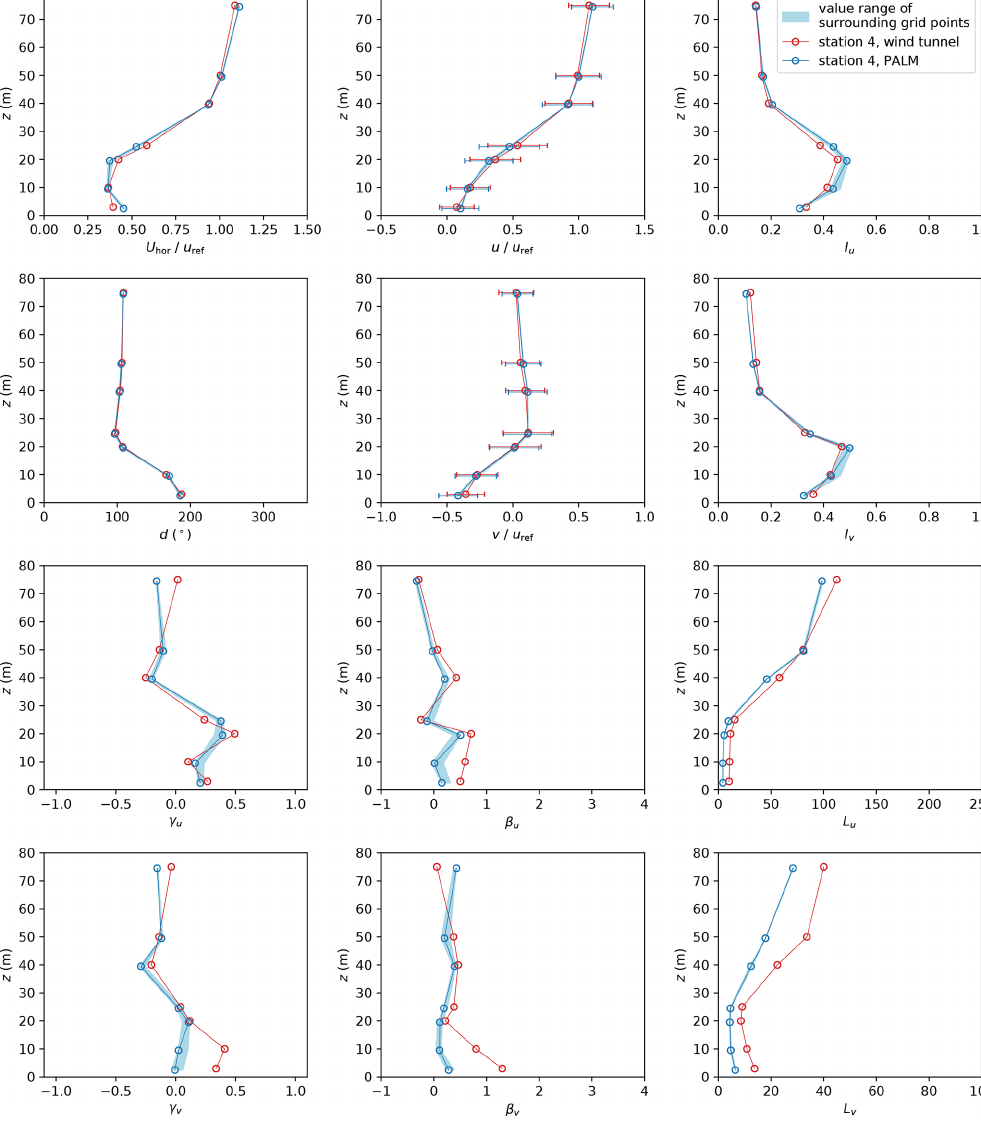
Figure 15. Profiles of mean horizontal wind speed U hor , wind direction d , and wind components u and v as well as turbulence intensity I , skewness γ , excess kurtosis β , and length scale L of both wind velocity components u and v at measurement station 4. Error bars denote the standard deviation of the respective quantity. Note that z = 0 denotes street-level